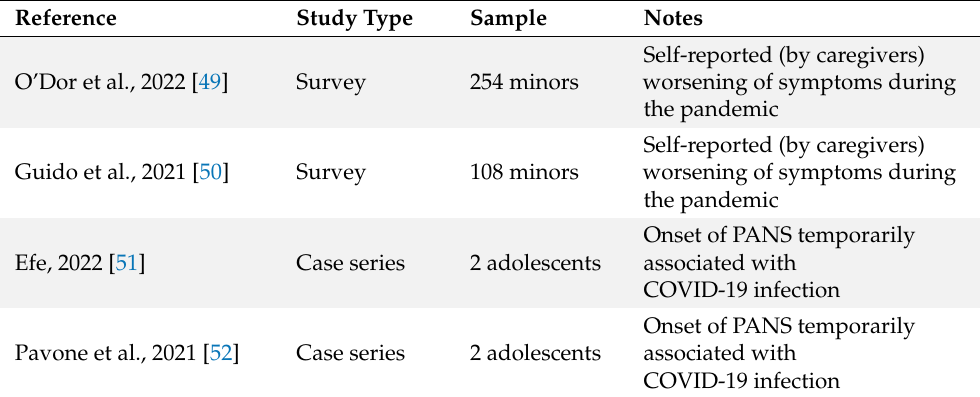
Table 2. Studies investigating PANS/PANDAS and